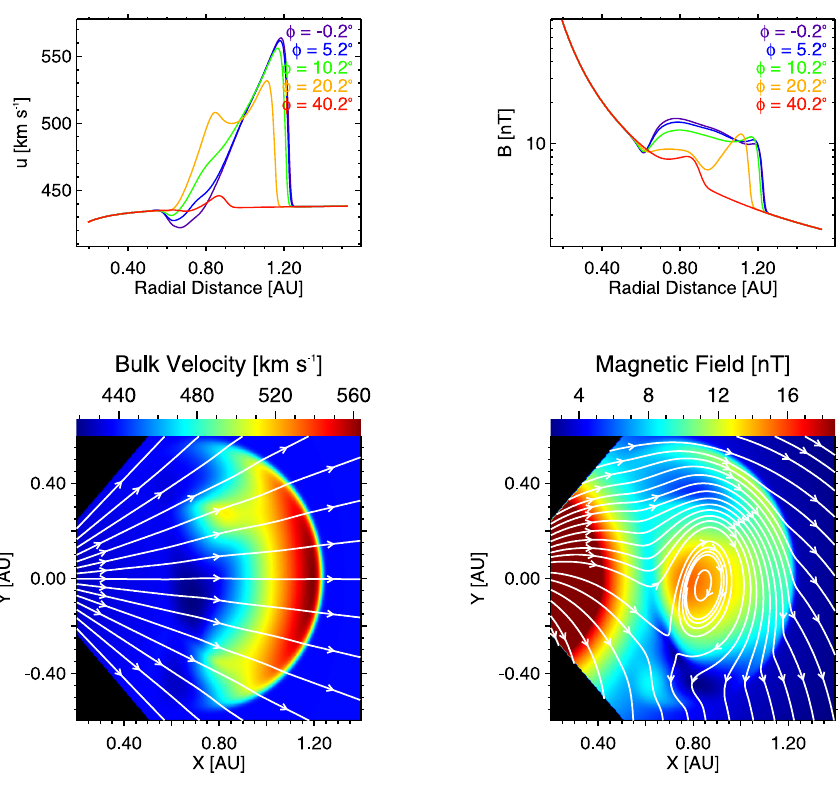
Fig. 2. Velocity distribution (bottom left) and magnetic field distribution (bottom right) for the H − e magnetic cloud at the distance of Earth (MC-center at ∼ 0.84AU). Corresponding profiles at constant azimuthal angels are shown in the top row. Velocity streamlines and magnetic field lines are over-plotted in white color,